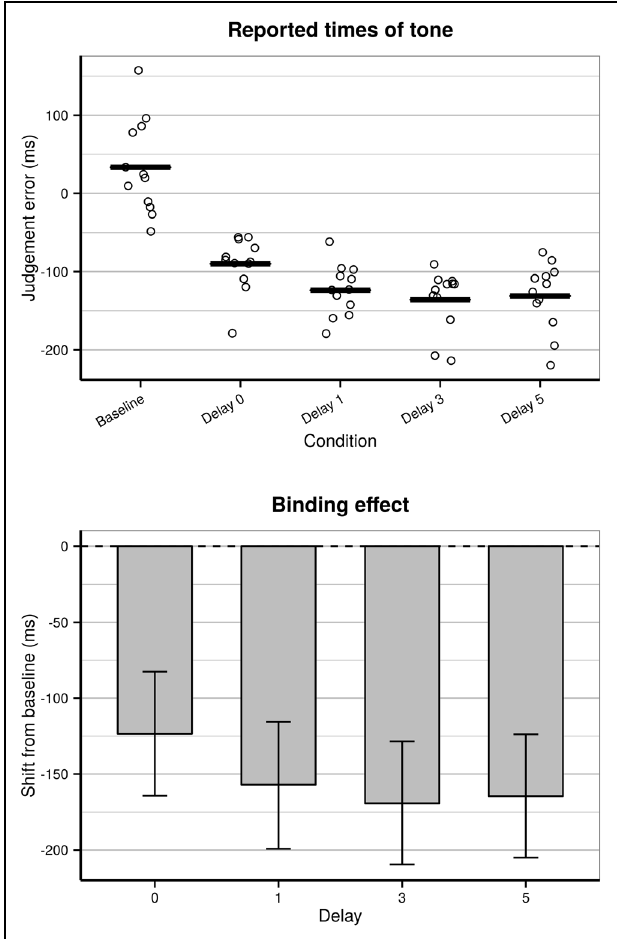
FIGURE 4 | (Top) Reported times of the tone relative to the actual occurrence of tone, for baseline condition, proximal condition, and the different delays. The dots indicate the individual time of report for each participant and the solid bars indicate the group level estimates. (Bottom) Group level estimated binding effect for tone in Experiment 2. Error-bars indicate 95% confidence intervals of the estimated effects based on posterior simulation ( n = 10000).